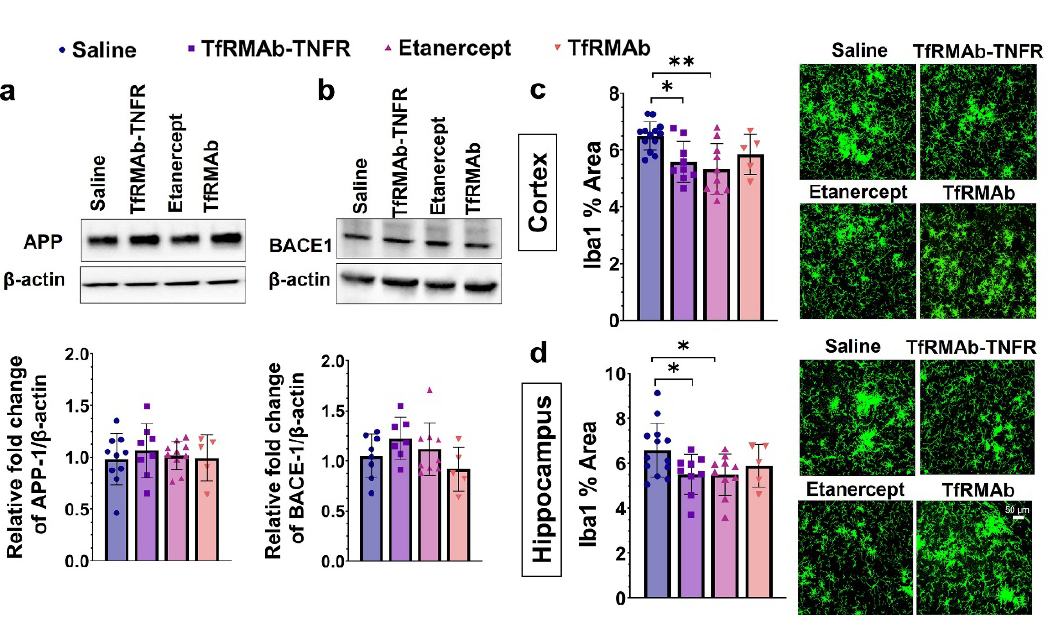
Figure 5. Effect of TfRMAb-TNFR on amyloid precursor protein (APP) and the β -site APP cleaving enzyme (BACE-1) levels, and microgliosis. There was no change in the protein levels of APP ( a ) or BACE-1 ( b ) between experimental groups by Western blotting of the cerebrum homogenates. TfRMAb-TNFR and etanercept reduced cortical ( c ) and hippocampal ( d ) Iba1-positive area. TfRMAb-treated mice showed no change in the Iba1-positive area. Scale bar = 50 μm. Data are presented as mean ± SD of n = 5–13 per treatment group, and data were analyzed using the one-way ANOVA with the Holm Sidak’s post hoc test. * p < 0.05, ** p < 0.01 for the indicated comparisons.